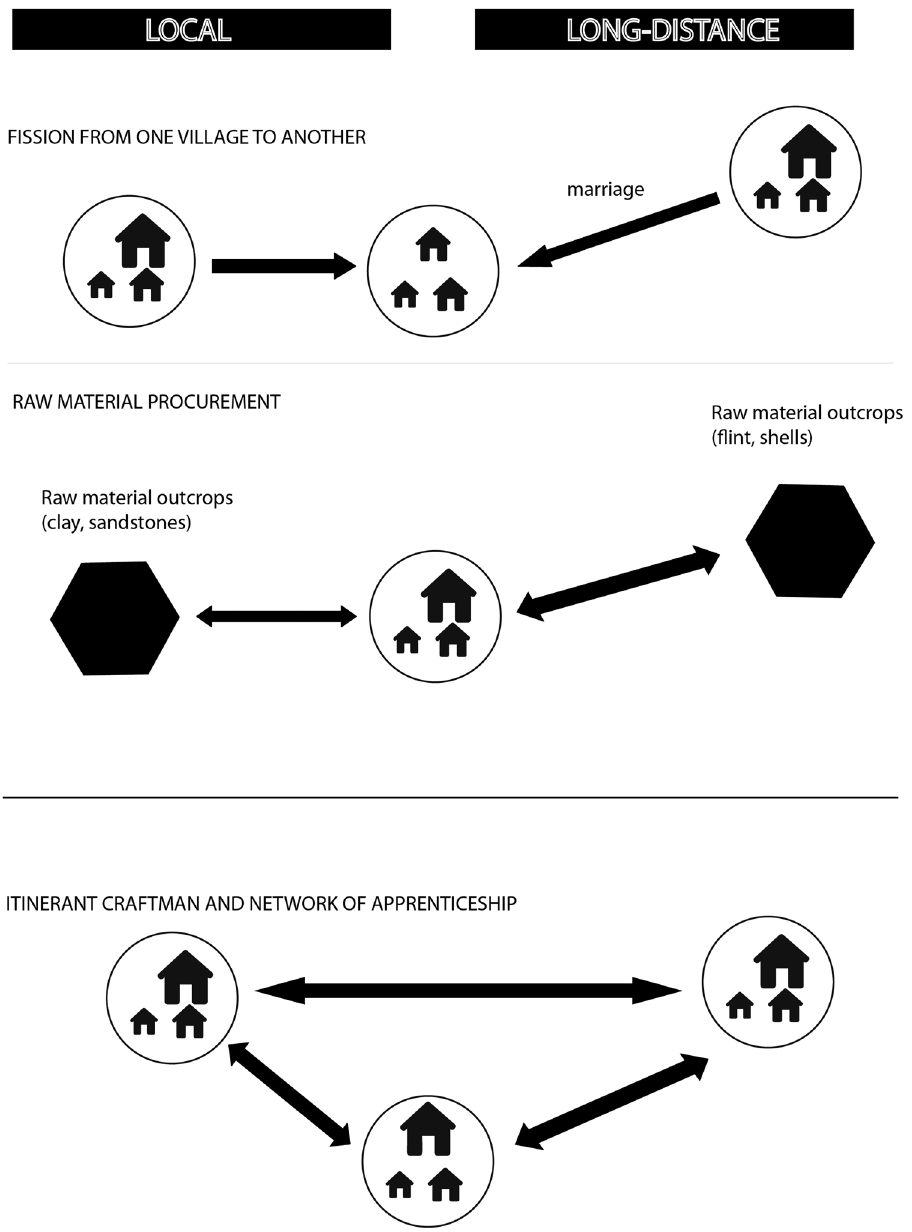
Figure 1: Schematic representation of di ff erent forms of LBK group and individual